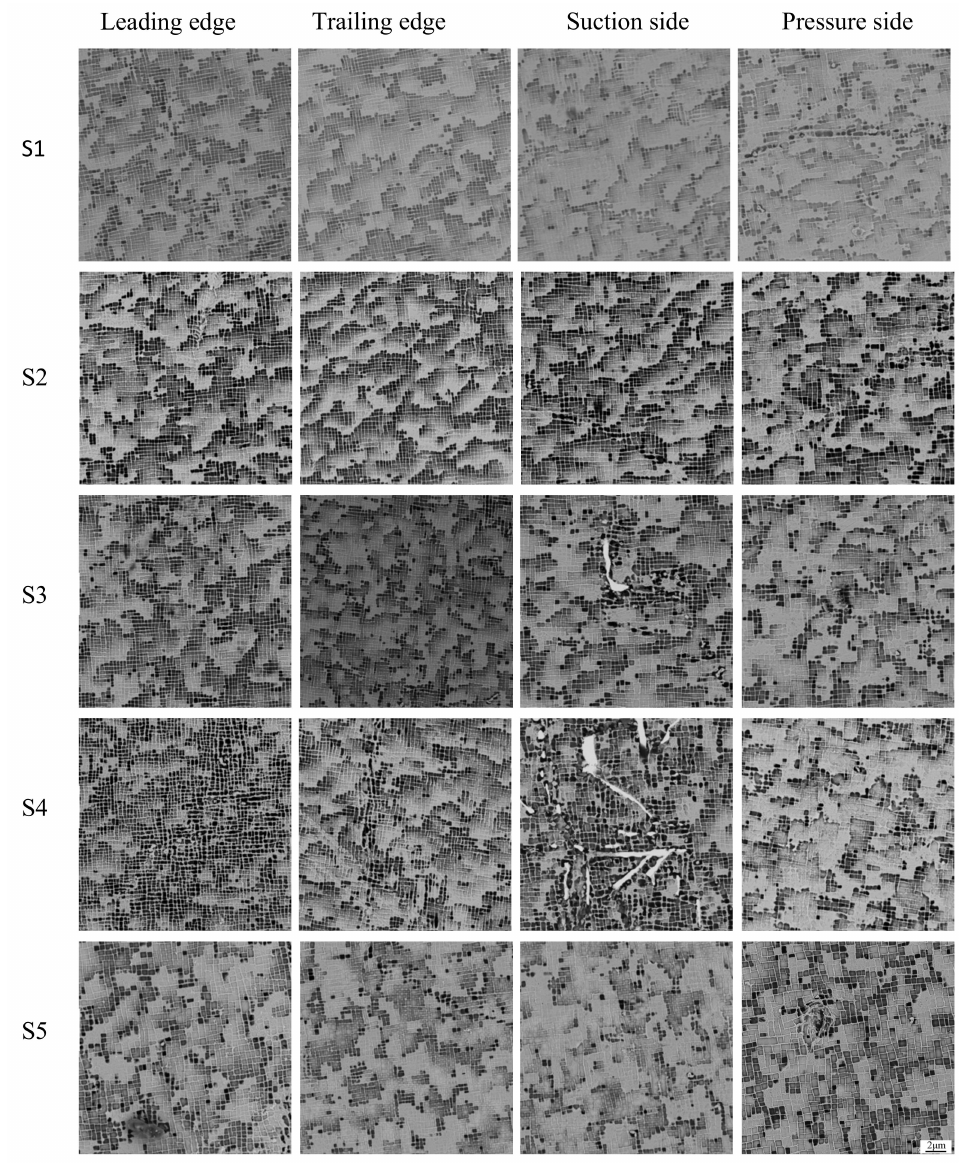
Figure 13. SEM images of γ / γ ’ microstructures at leading edge, trailing edge, suction side and pressure side of transverse sections 1–5 of the